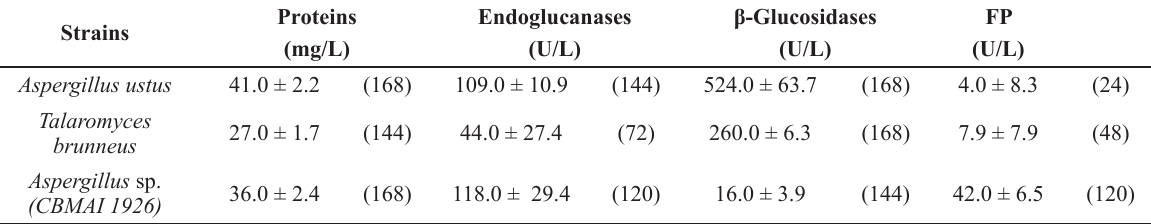
Mean and standard deviation of the maximum protein concentration and maximum volumetric activities of endoglucanases, β-glucosidases and FP during submerged cultivation of fungal strains isolated from Catão cave (numbers in parenthesis corresponds to the cultivation time in hours).